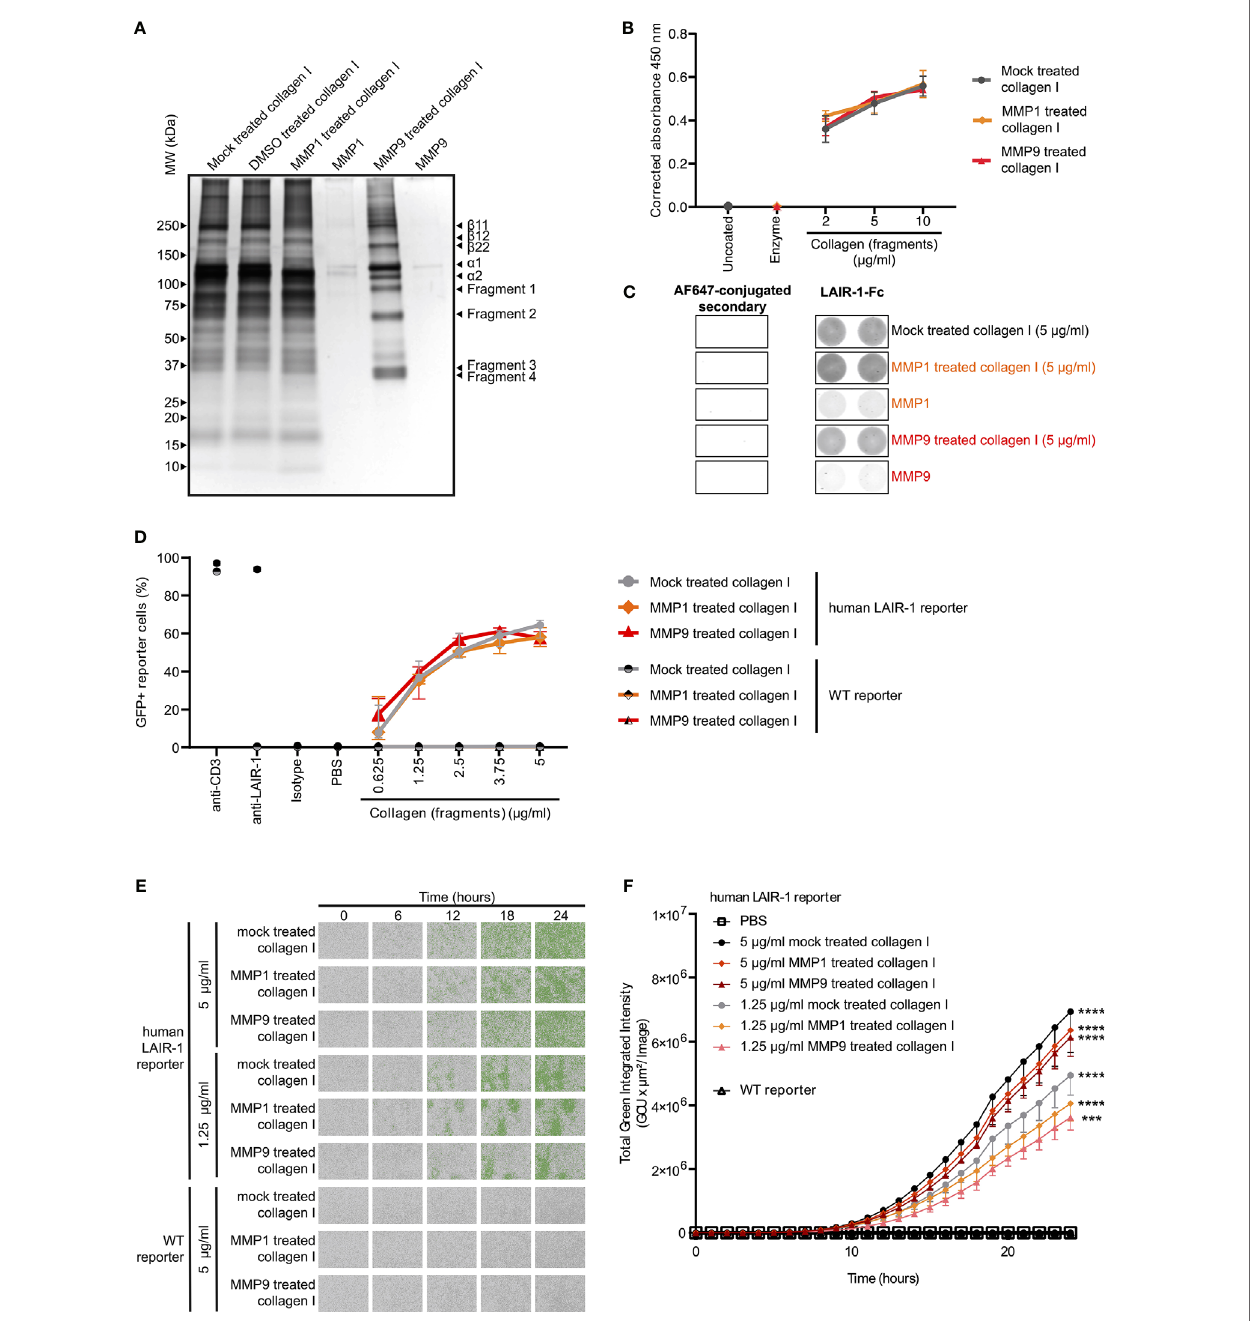
FIGURE 2 | MMP1 and MMP9 generated collagen I fragments bind to and activate LAIR-1. (A) Analysis of MMP1 and MMP9 generated collagen I fragments by SDS-PAGE and silver staining. Representative image of n = 3. (B, C) LAIR-1-Fc protein binding to mock treated, MMP1 treated and MMP9 treated collagen I. (B) LAIR-1-Fc ELISA based immune binding assay (n = 3 with technical duplicates). (C) LAIR-1-Fc fl uorescence based immune binding assay. Representative images show immuno fl uorescence by the AF647-conjugated secondary antibody alone or by secondary antibody binding to LAIR-1-Fc, representative of n = 3. (D) Flow cytometry analysis of NFAT-GFP reporter cells, representing LAIR-1 ligation (n = 3 with technical duplicates). Anti-human-LAIR-1 and anti-mouse-CD3 are positive controls for reporter cell activation. The isotype antibody and PBS are negative controls. (E) Representative images by live-cell IncuCyte imaging upon stimulation with indicated concentrations of collagen and collagen fragments (n = 3). (F) Quanti fi cation of the total green integrated intensity in the images from the live-cell IncuCyte imaging over time (n = 3 with technical duplicates). Signi fi cant differences at t = 24 hours compared to WT reporter cells are indicated, tested using a two-way ANOVA with Tukey ’ s multiple comparison correction. In all panels symbols represent the mean and whiskers indicate the standard